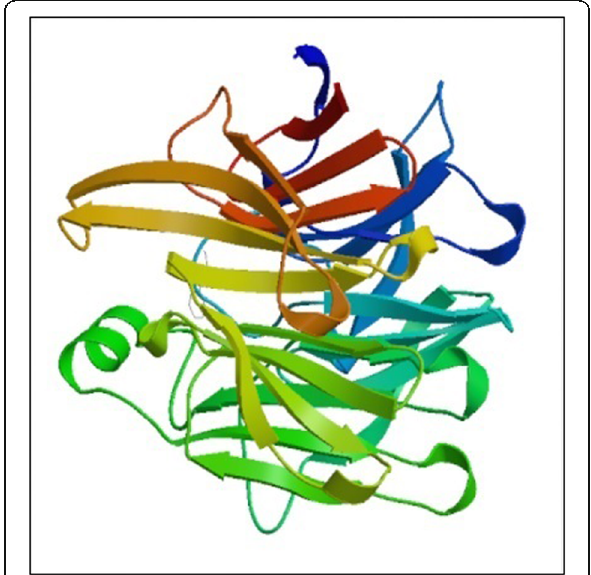
Fig. 1 Predicted 3D structure of